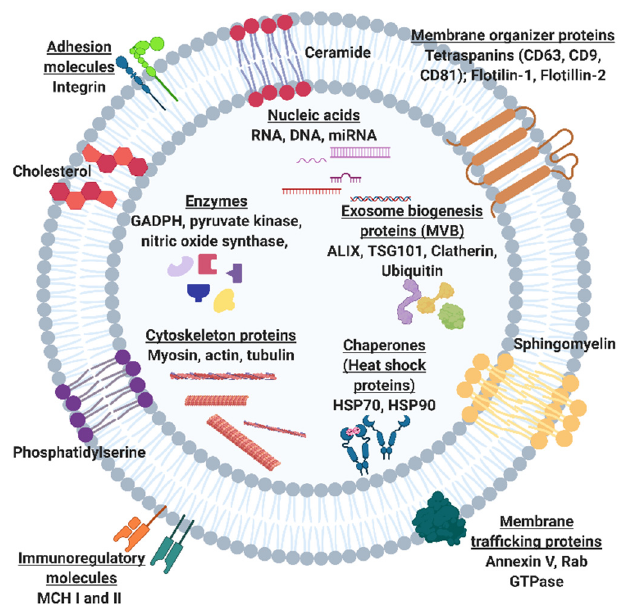
Figure 1. Schematic of exosome including intracellular cargo and surface proteins and macromolecules. Common exosome surface markers include tetraspanins CD63, CD81, CD9, flotillins 1 and 2. Common intracellular markers include exosome biogenesis markers ALIX, a programmed cell death 6 interacting protein, and tumor suppressor gene 101 (TSG101) and enzymes such as glycolytic enzyme, Glyceraldehyde 3-phosphate dehydrogenase (GADPH) and nitric oxide synthase.